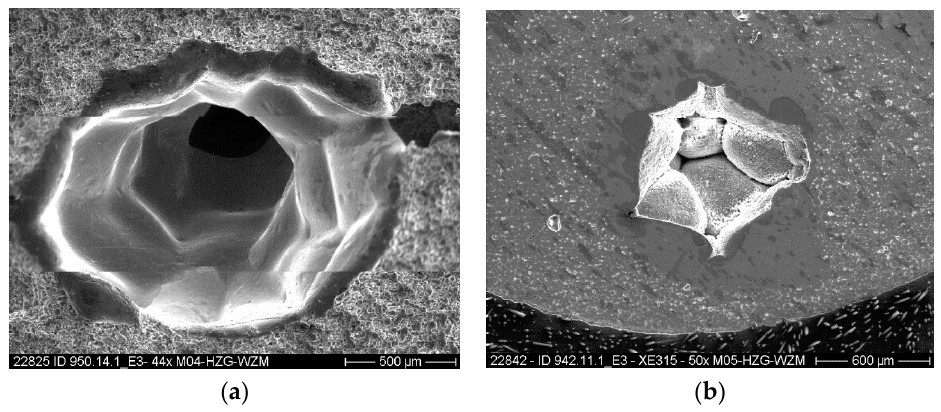
Figure A1. ( a ) shows the SEM ‐ SE fracture surface of thermal debound and sintered MIM dogbone shape tensile test specimen after 64 h sintering time using PPcoPB copolymer showing a partly enclosed jetting channel inside of the part; ( b ) shows the SEM ‐ SE micrograph of the same phenomena shown in Figure A1a.